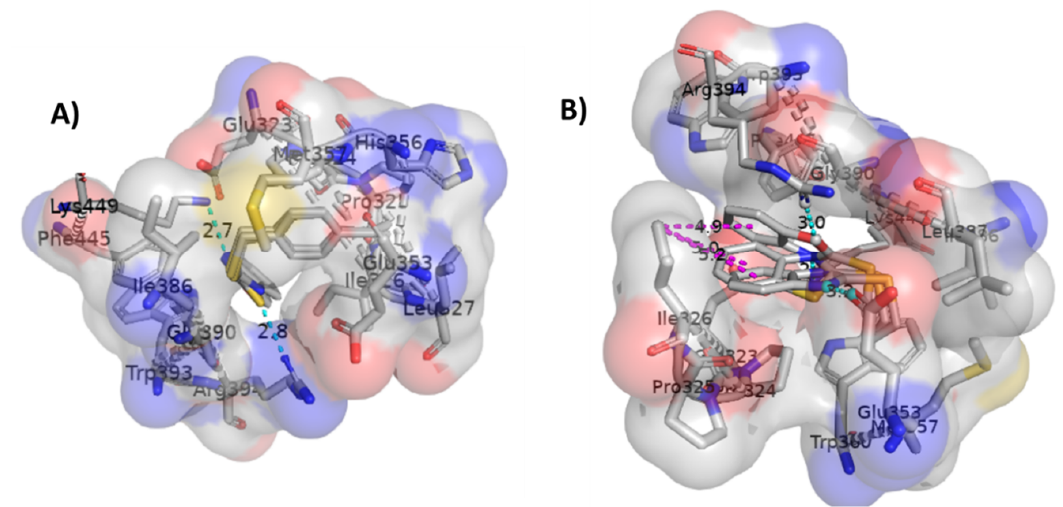
Figure 2. Interactions maps between receptor Erα and molecules ( A ) BTA-1 , BZM-2 , and BOX-3 ( B ) BTA-4 , BZM-5 , and BOX-6 . Cyan dashed lines are hydrogen bonds, magenta are pi–alkyl interactions, and yellow are pi–sulfur interactions.